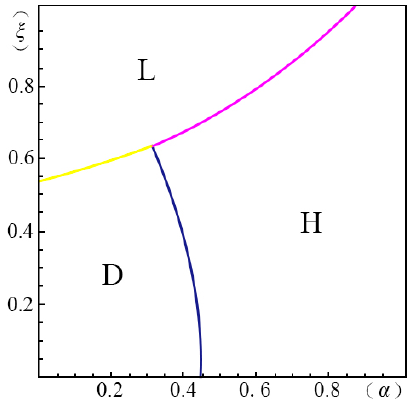
− p 1 A ≤ p 1 A + kg − p (cid:3409) (cid:3043) (cid:3117)(cid:3250) (cid:3397)(cid:1863)(cid:1859) (cid:2879)(cid:3043) when p 2 A when (cid:3043) (cid:3118)(cid:3250) (cid:2879)(cid:3043) (cid:3117)(cid:3250) . 2 λσδ Q − 1 σδ Q ( 1 − λ ) (cid:3097)(cid:3083)(cid:3018)(cid:4666)(cid:2869)(cid:2879)(cid:3090)(cid:4667) (cid:2870) (cid:3090)(cid:3097)(cid:3083)(cid:3018)(cid:2879)(cid:2869)